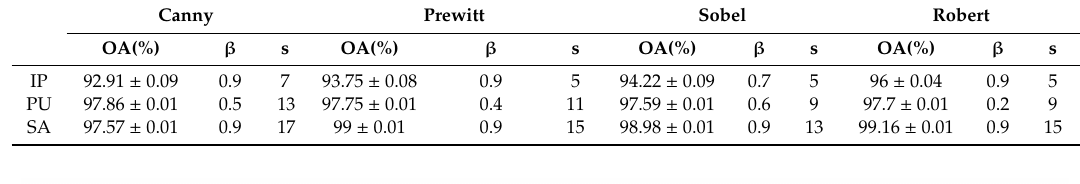
Table 6. The best results (mean and standard deviation) obtained by using four operators on Indian Pines (IP), Pavia University (PU) and Salinas (SA) datasets. Canny Prewitt